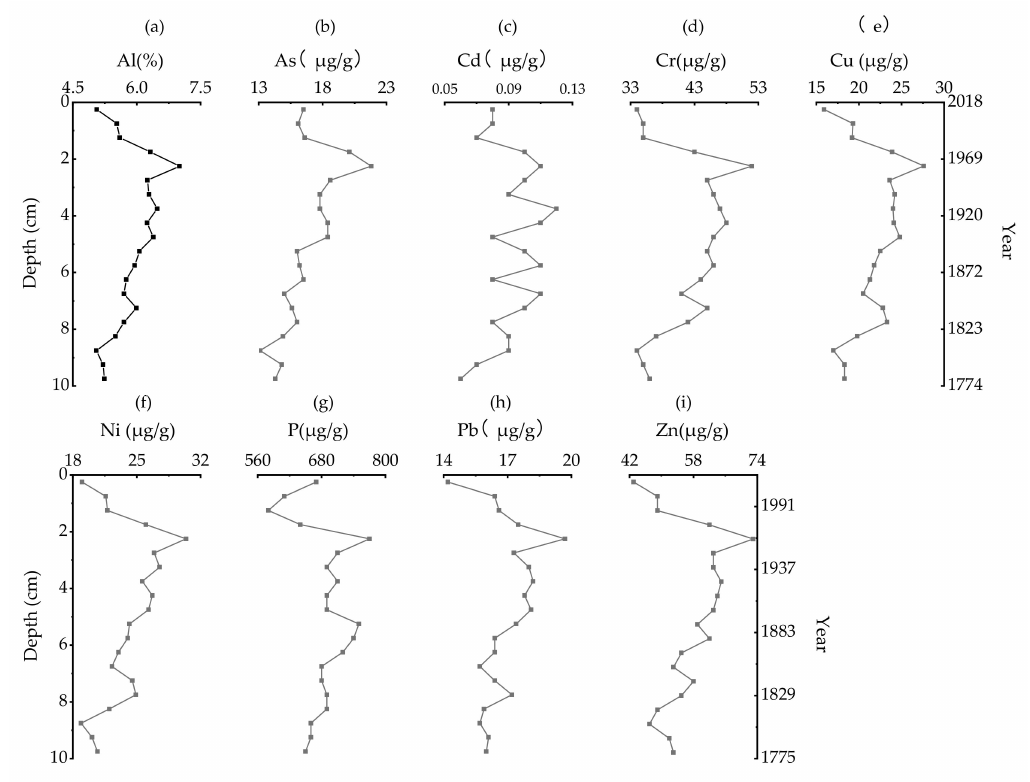
Figure 3. The vertical distribution of the elements of ( a ) Al, ( b ) As, ( c ) Cd, ( d ) Cr, ( e ) Cu, ( f ) Ni, ( g ) P, ( h ) Pb, and ( i )